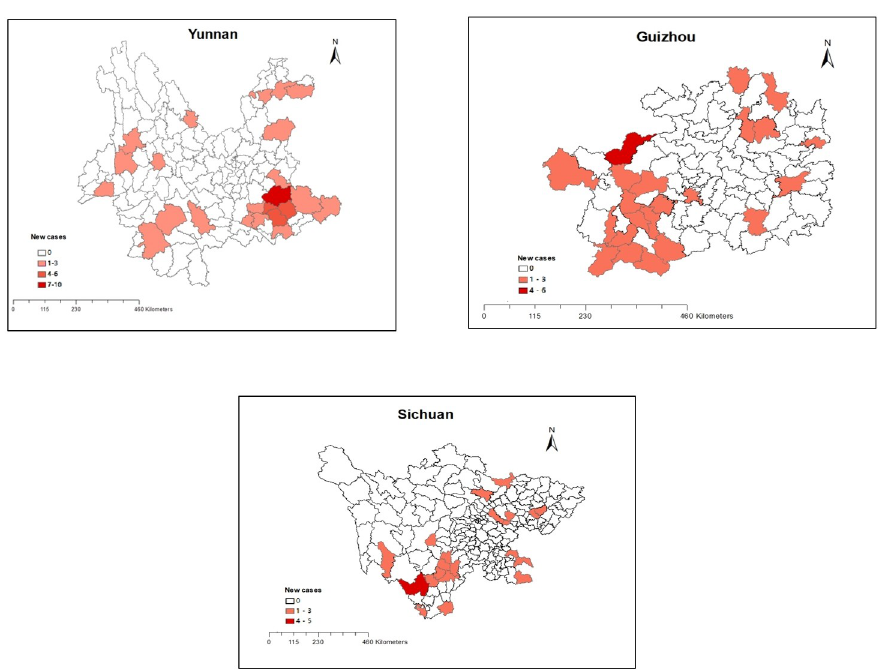
Fig 2. Spatial Distribution of pediatric new cases in Yunnan, Guizhou and Sichuan, China, 2011–2020. The base layers of the map are extracted from Naive Map developed in AMAP with data from the National Catalogue Service For Geographic Information. https://www.naivemap.com/admin-cn-downloader/.